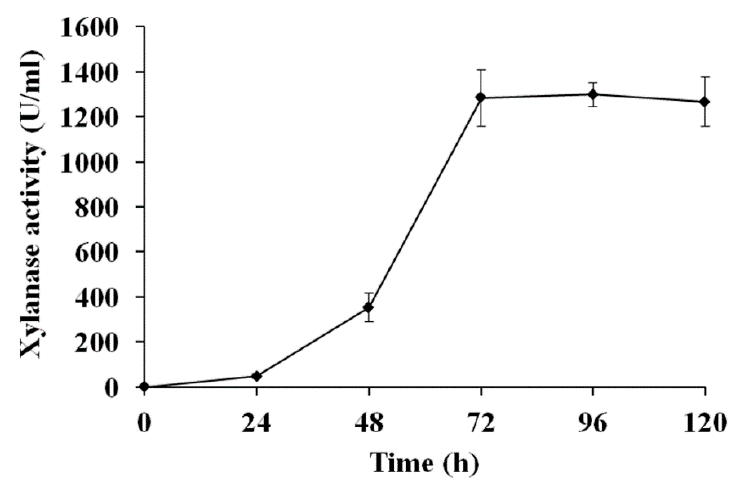
Figure 2. Recombinant xylanase production by P. pastoris pPICZ α A-optiXynB.